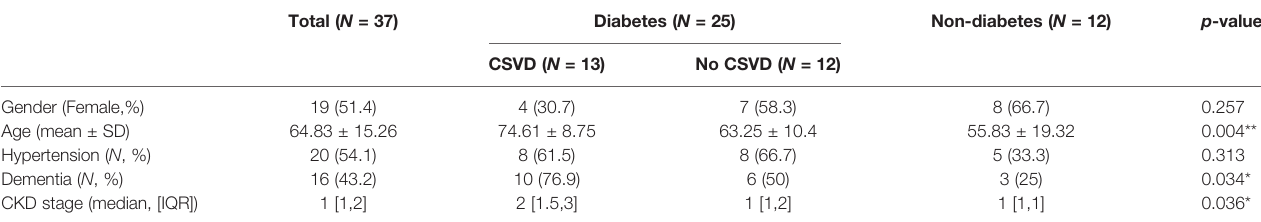
DM, diabetes mellitus; CSVD, cerebral small vessel disease; CKD, chronic kidney disease; SD, standard deviation; *p < 0.05; **p <